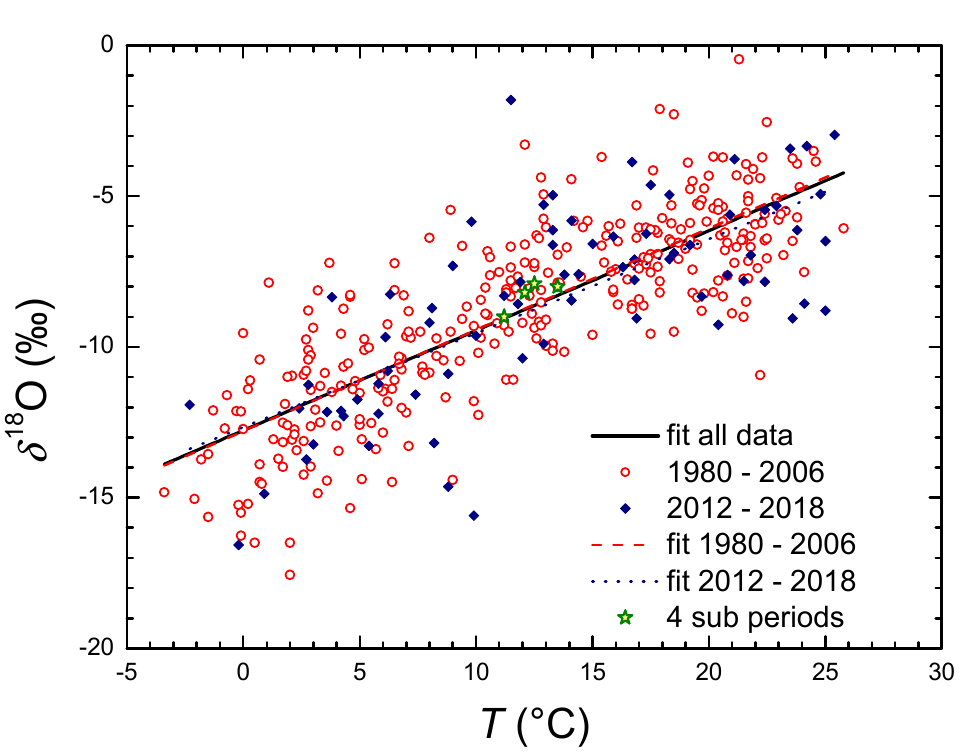
Figure 14. Temperature dependence of δ 18 O in monthly precipitation at the Zagreb station during different periods. Regression lines are represented by Equations (6) and (8). The mean values in the subperiods (stars) are taken from Table 2.